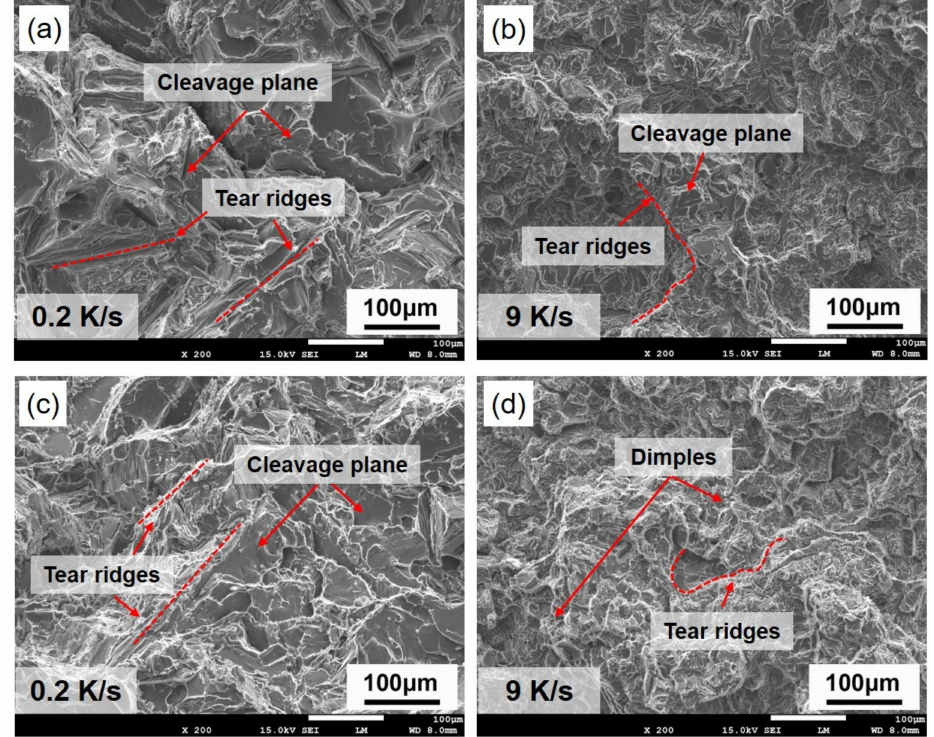
Figure 8. SEM pictures showing the fractures of ( a , b ) Al7SiMg and ( c , d ) Al7SiMg + 0.4La at the cooling rate of 0.2 and 9 K /